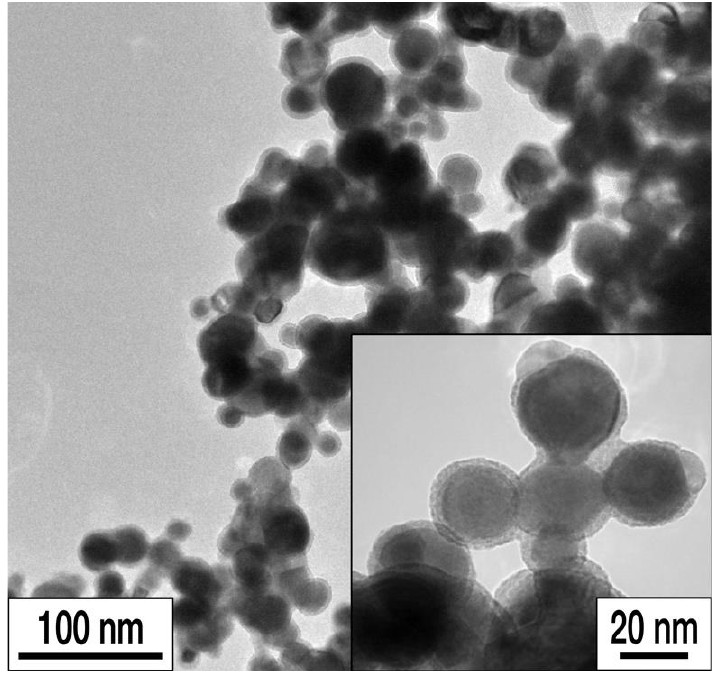
Figure 1. TEM image of W-5Ni-2Fe nanopowder.